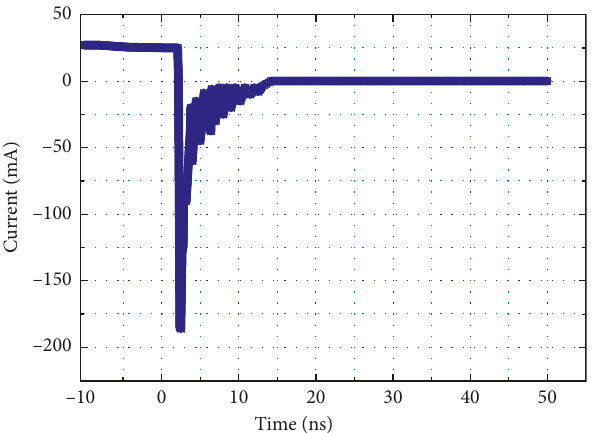
Figure 10: Oscillogram of the current switching diode based on